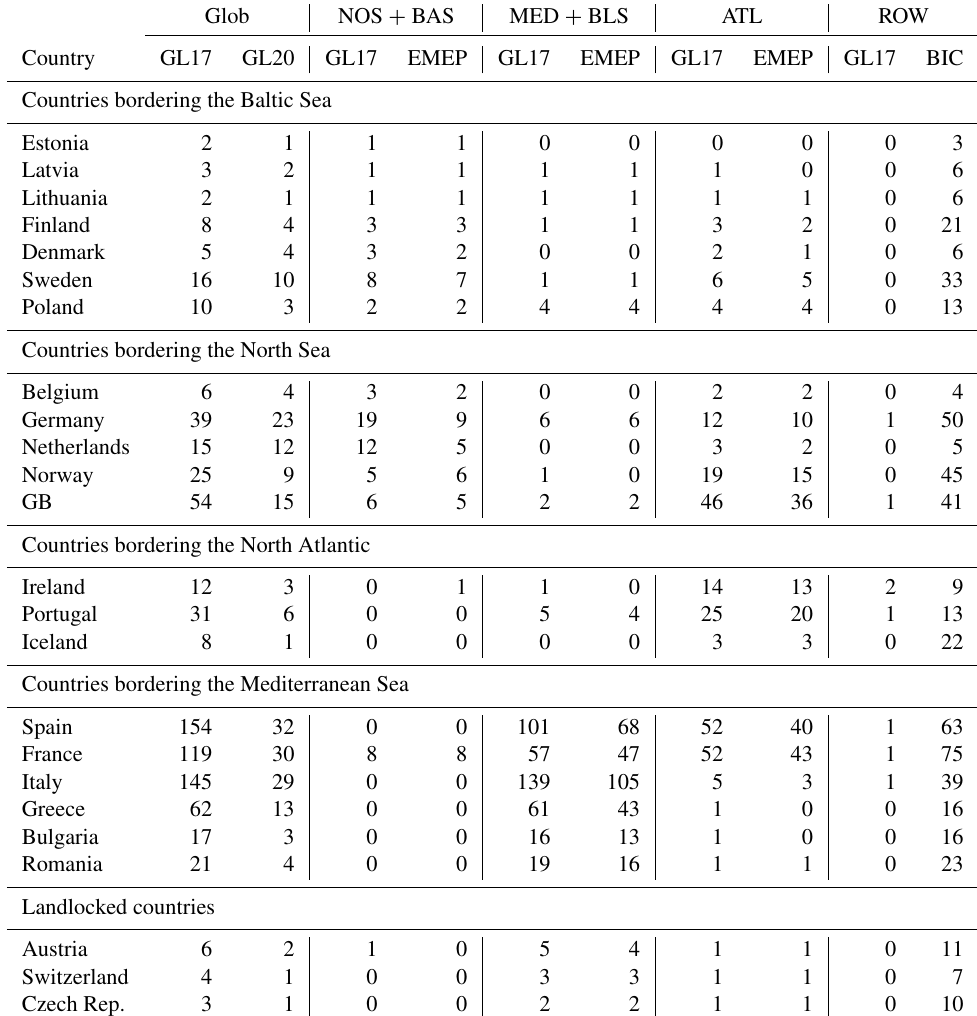
Table 6. Source receptor relationships for depositions of oxidised S from shipping as calculated by the global model and as reported for the year 2017. Glob is the contribution from all global shipping, NOS + BAS from the North Sea and Baltic Sea combined, MED + BLS from the Mediterranean Sea and Black Sea combined, and ATL from the north-east Atlantic. GL17 is from the global model calculations, and EMEP is from Appendix B in EMEP Status Report 1/2019 (2019) (units: 100Mg of S per 15% emission reduction multiplied by 100 / 15; parts per billion per day per 15% emission